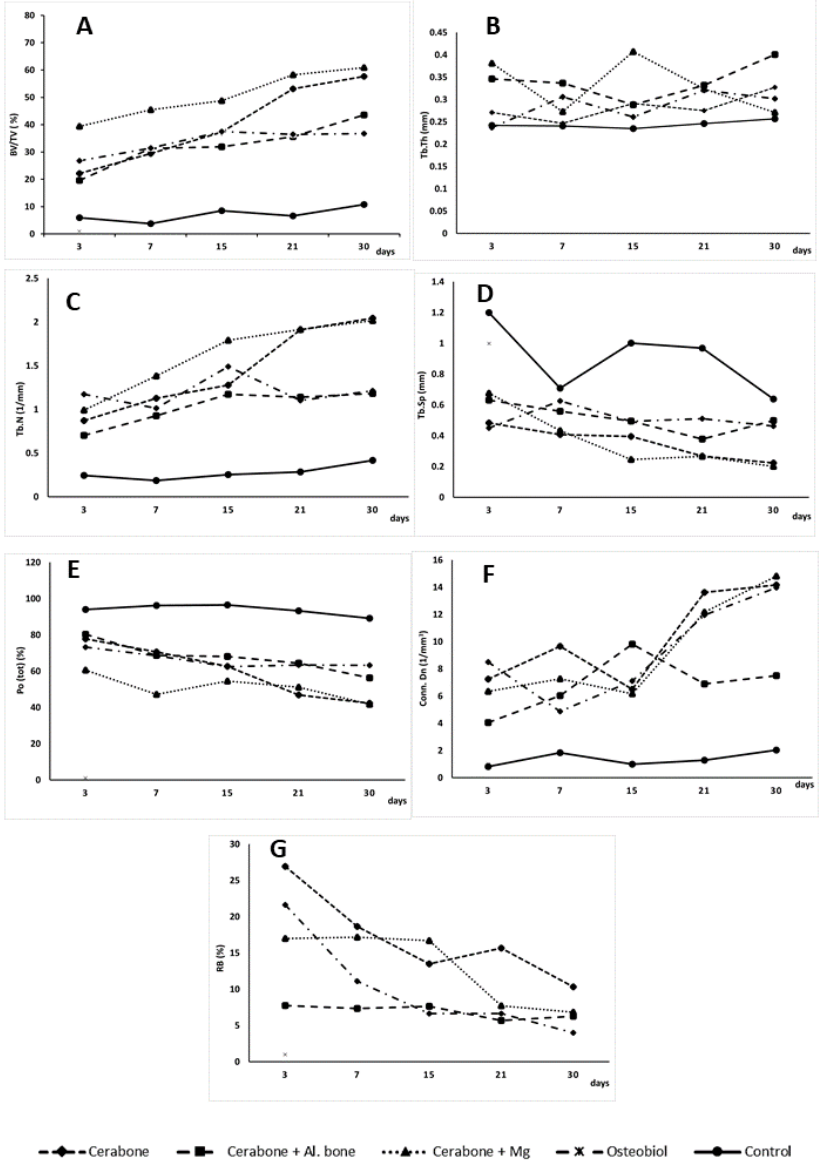
Figure 1. Medians of bone morphometric parameters: ( A ) BV/TV = bone volume; ( B ) Tb.Th = trabecular thickness; ( C ) Tb.N = trabecular number; ( D ) Tb.S = trabecular separation; ( E ) Po (tot) = total porosity; ( F ) Conn. Dn = connectivity density; and ( G ) RB = residual biomaterial as a function of days (3, 7, 15, 21, and 30) and xenogeneic biomaterial groups and control (- ♦ - Cerabone ® ; - ■ - Cerabone ® + Al. bone; - ▲ - Cerabone ® + Mg; -x- Osteobiol ® ; - ● - control).